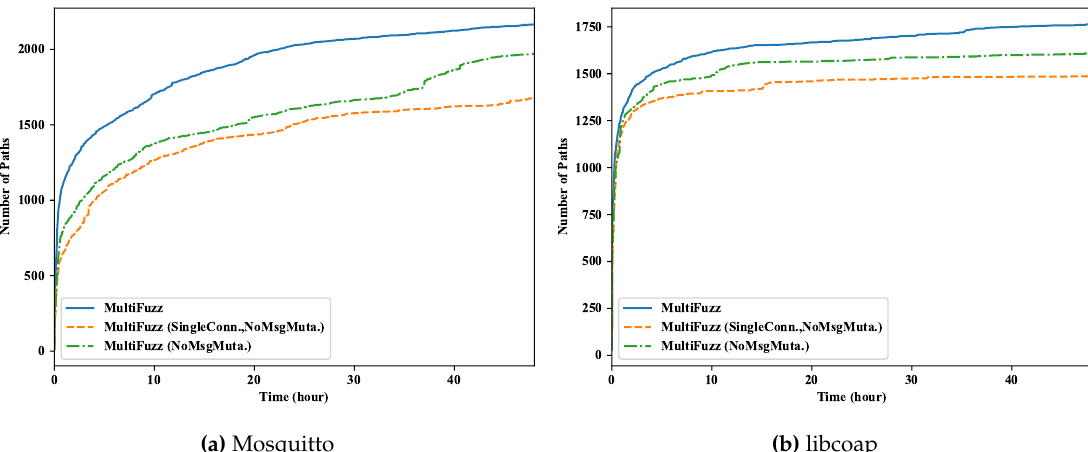
Figure 9. The paths discovered when disabling both the multi-connection design and the message mutation algorithm (MultiFuzz (SingleConn., NoMsgMuta.)), and disabling only the message mutation algorithm (MultiFuzz